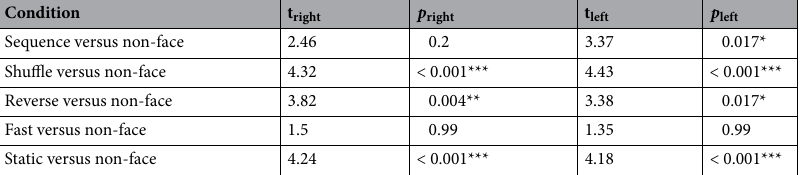
Table 1. The pairwise comparisons of the conditions at the right and the left hemispheres for harmonics. P values and confidence intervals are corrected using Bonferroni method. * p < 0.05 , ** p < 0.01 , *** p < 0.001 .